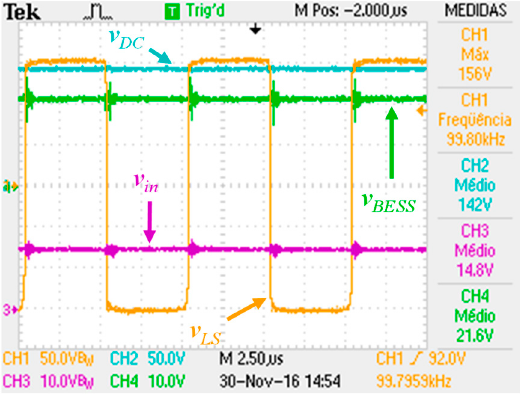
Figure 15. Experimental results of the DC–DC power converter: Input voltage ( v in ), BESS voltage ( v BESS ), DC-link voltage ( v DC ) and secondary winding voltage ( v LS ) when the transformer operates with a 50% duty cycle.